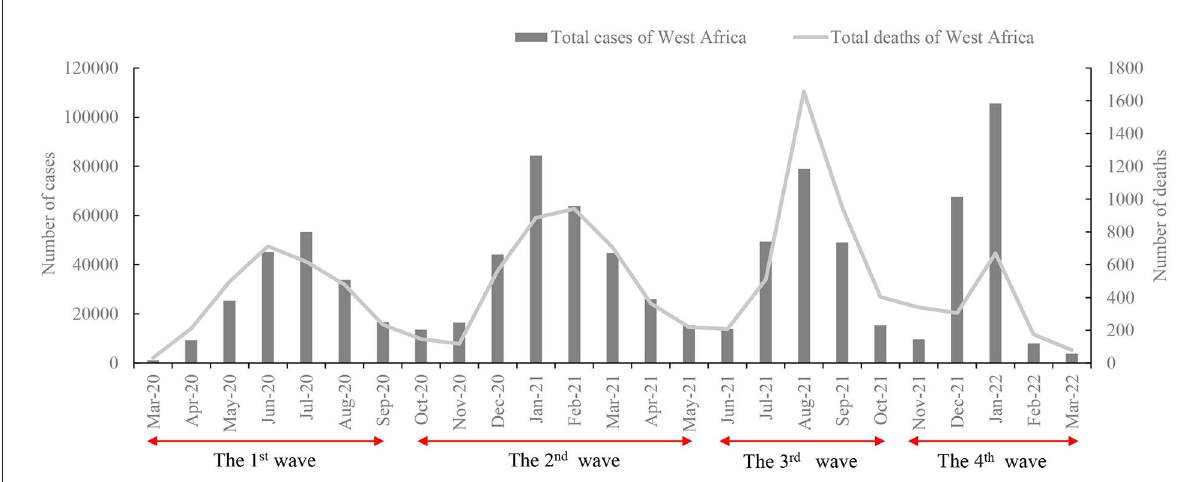
FIGURE1 Evolution of cases and deaths in West Africa from March 2020 to March 2022.